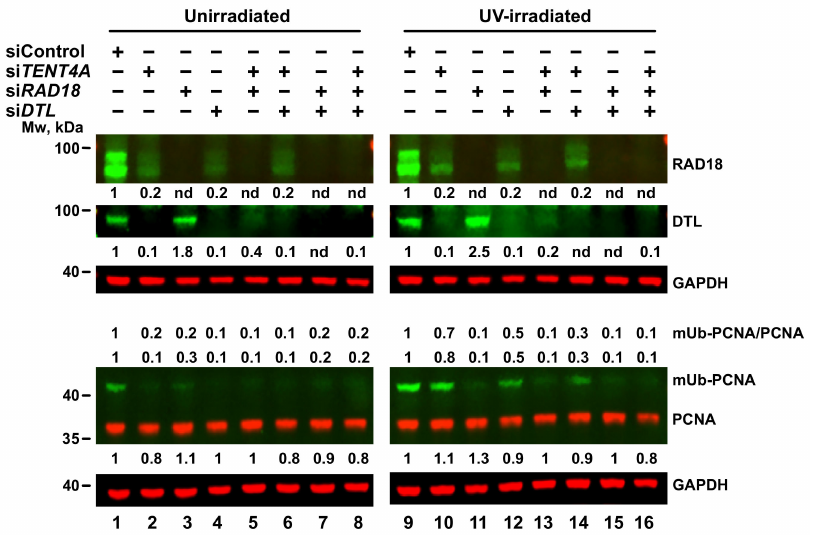
Figure 4. Interrelationship among TENT4A, RAD18 and DTL in determining amounts of RAD18 and DTL and the extent of PCNA monoubiquitination. MCF-7 cells were transfected with siRNA against TENT4A , RAD18 and DTL or their double or triple combinations. At 65 h post-transfection, the cells were UV-irradiated at 20 J/m 2 and harvested 6 h post-irradiation. Whole-cell extracts were fractionated by SDS-PAGE followed by Western blot with indicated antibodies. Protein levels were normalized to GAPDH and presented each relative to its level in unirradiated or UV-irradiated siControl-treated